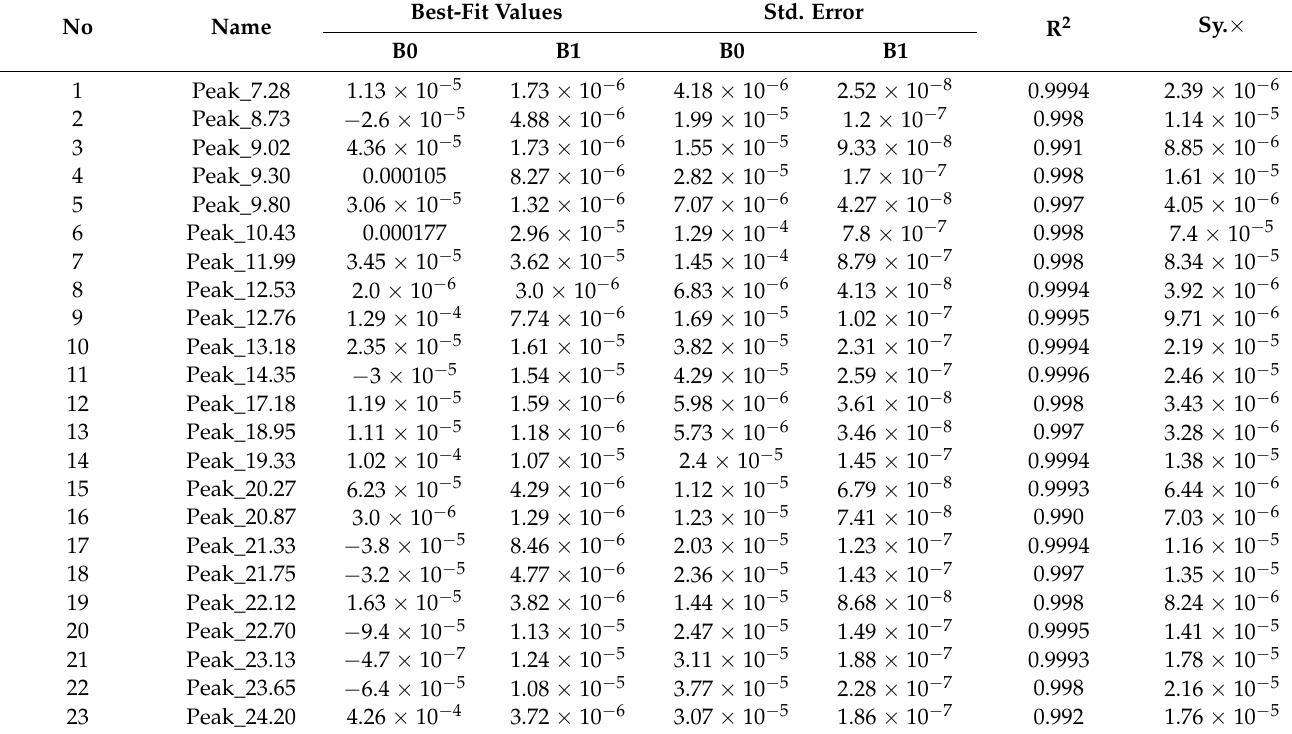
Table 1. The best-fit values B0 and B1, the standard errors associated to the coefficients, the correlation coefficient (R 2 ) and the standard error of the estimate (Sy.x) of the 23 linear models for the CMS peaks, as they were calculated by the MEPHAS